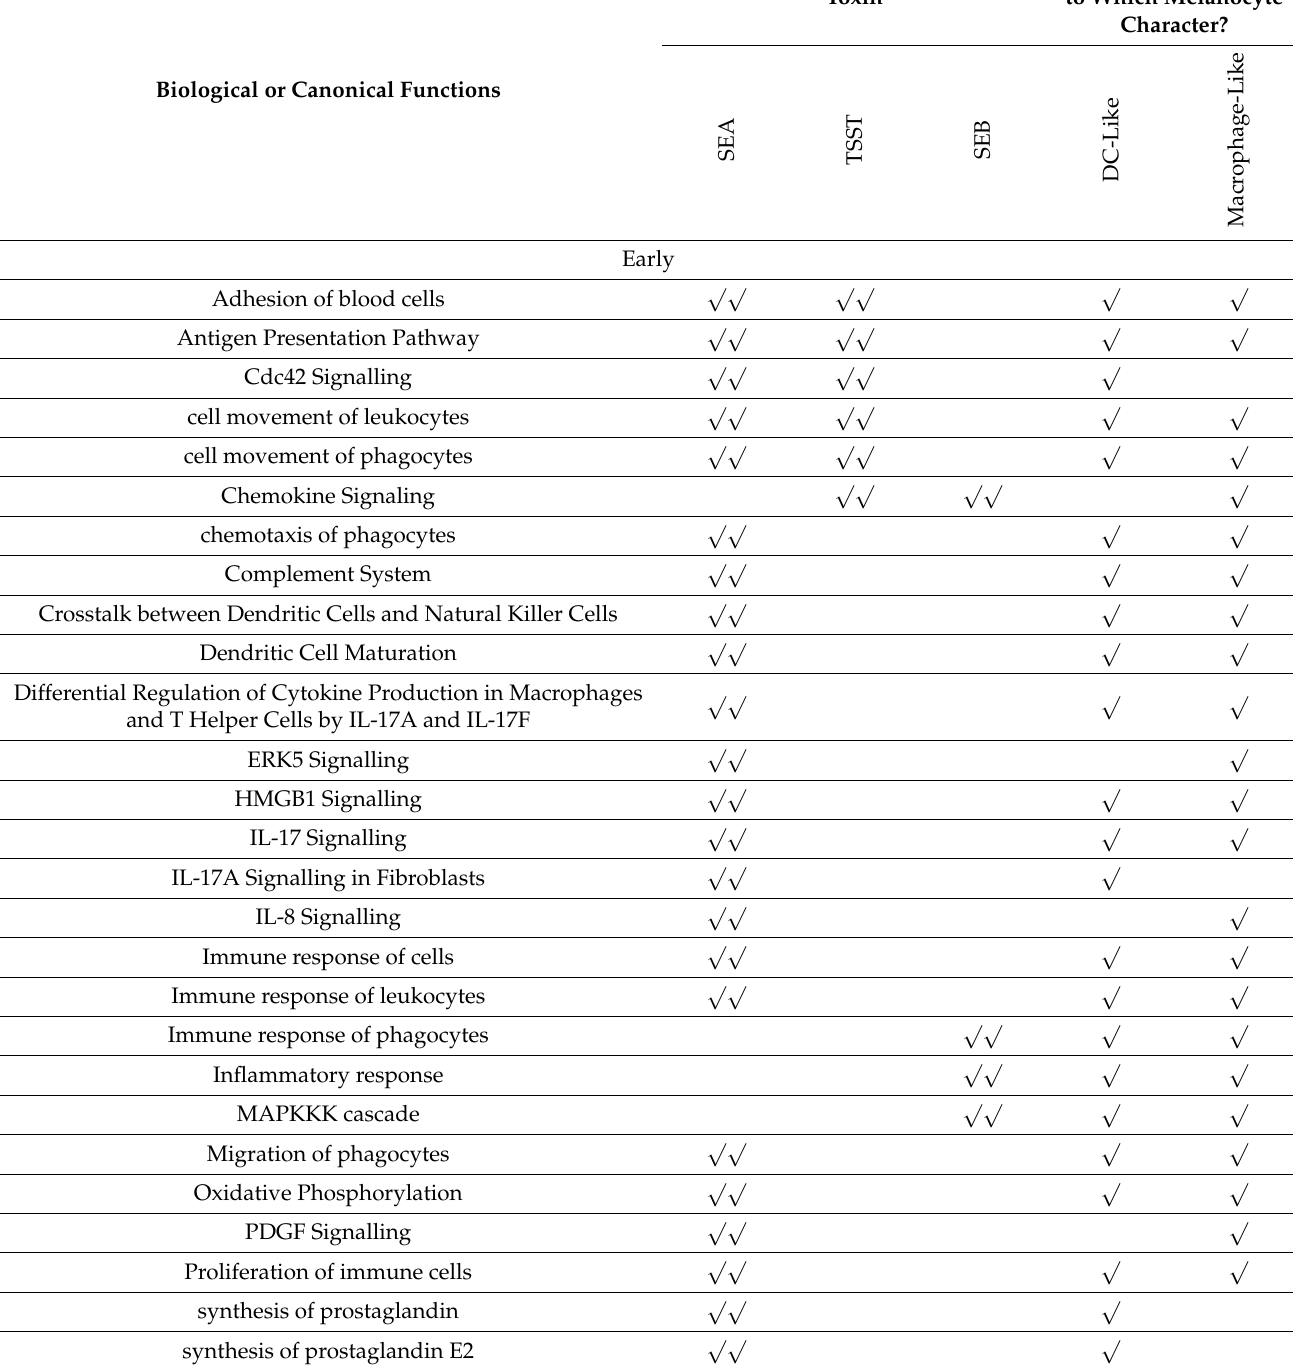
Table 1. Biological pathways ( p < 0.001) and canonical functions ( p < 0.01) that represent melanocytes’ dendritic cell-like (DC-like) or macrophage-like property. Networks which are perturbed by the √√ toxins are double tick ( ) marked. In addition, the association of the networks with DC-like and/or √ macrophage-like properties are noted by single tick ( )